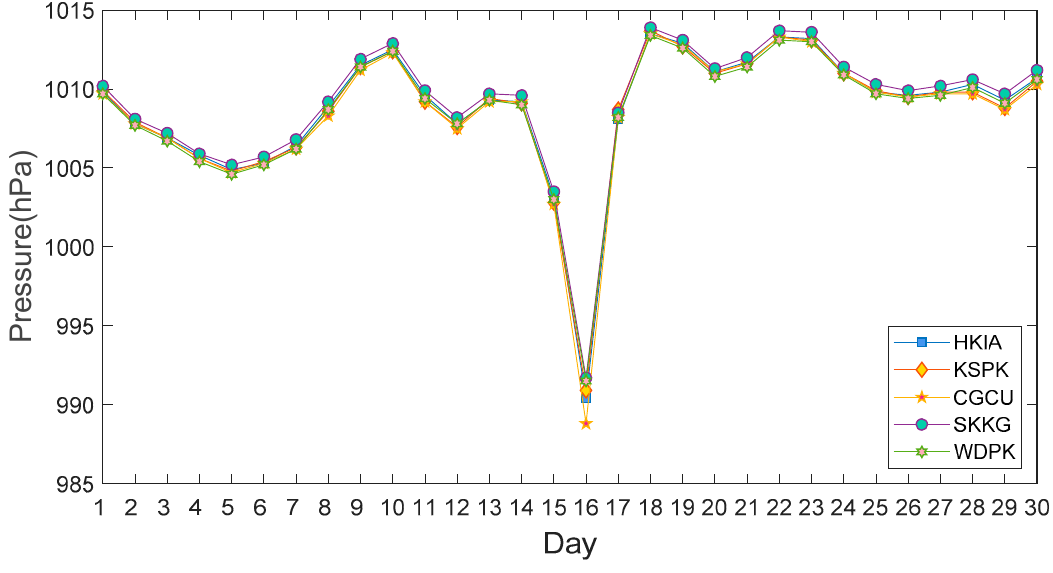
Figure 6. Daily mean pressure over each weather station in September.